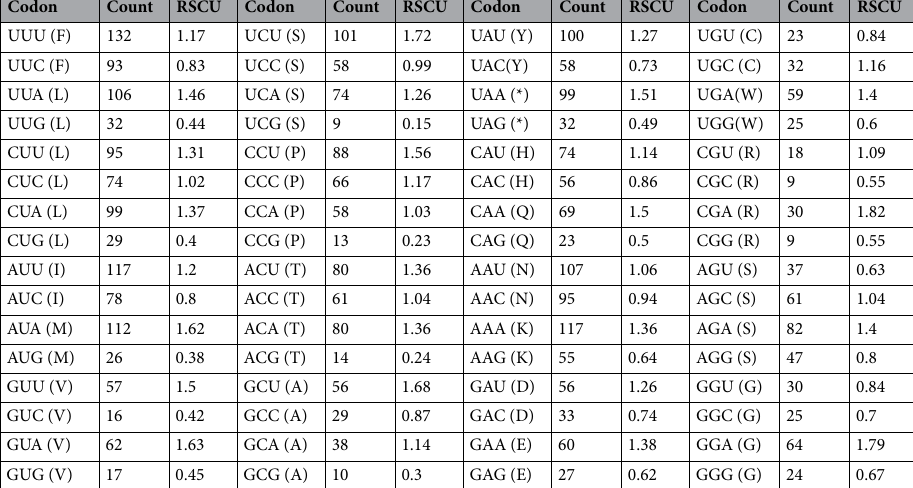
Table 3. Codon number and relative synonymous codon usage in the Exhippolysmata ensirostris mitochondrial